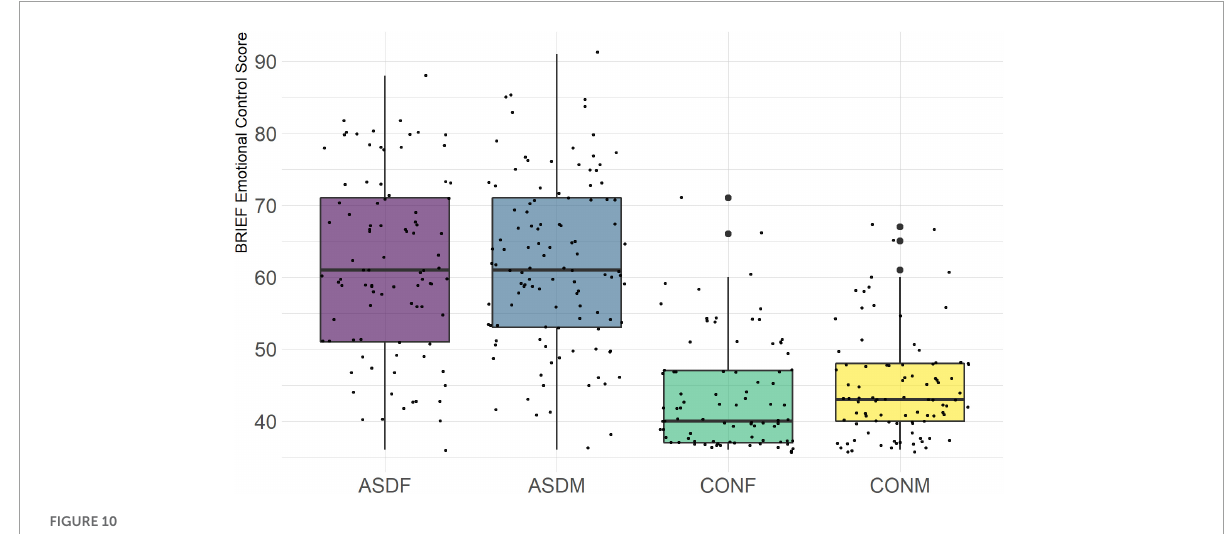
FIGURE10 BRIEF Emotional Control Subscale.